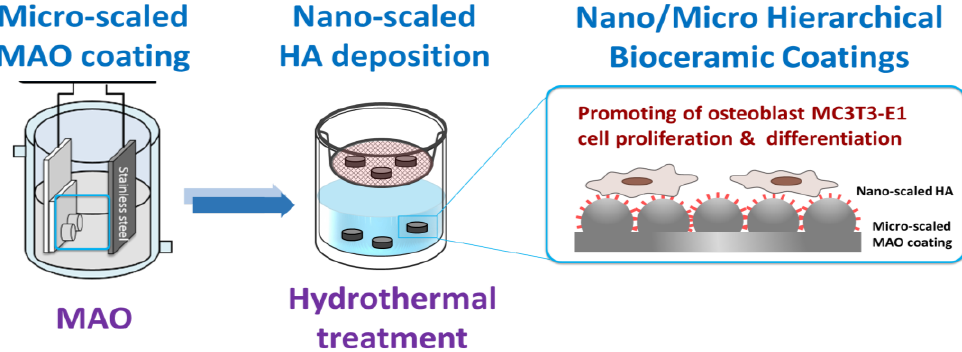
Figure 1. Diagram of the hierarchical structures combined with micro-scaled micro-arc oxidation (MAO) and nano-scaled hydroxyapatite (Ca 10 (PO 4 ) 6 (OH) 2 , HA).